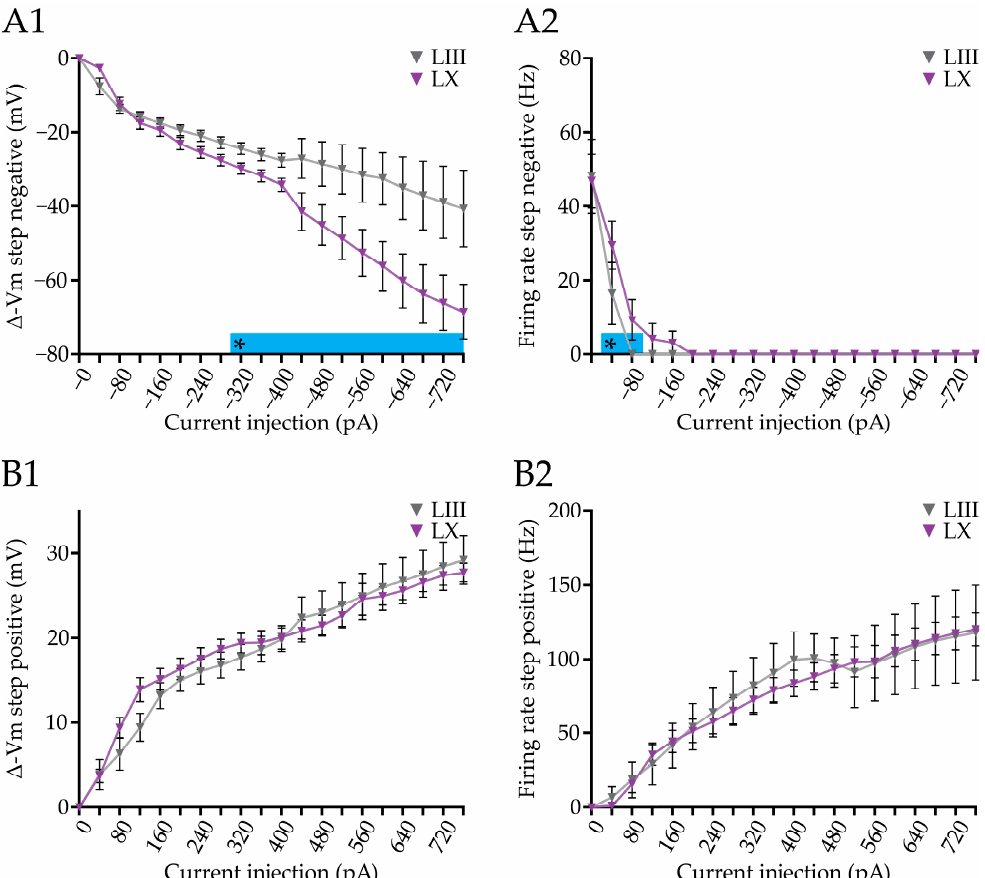
Figure 5. Responses to positive and negative current injections in Purkinje cells of juvenile mice. ( A ), Recordings from PCs in LIII and LX of P15–17 mice. Analysis of the change in membrane potential ( A1 ) and firing rate ( A2 ), induced by negative current injections (0 to − 760 pA) starting from a membrane potential of − 55 mV. ( B ), Similar analysis for the responses in change in membrane potential ( B1 ) and firing rate ( B2 ) to the injection of positive current pulses (0 to 760 pA) starting from a membrane potential of –65 mV. Asterisk denotes p < 0.05. See Table S5 for all statistical data.